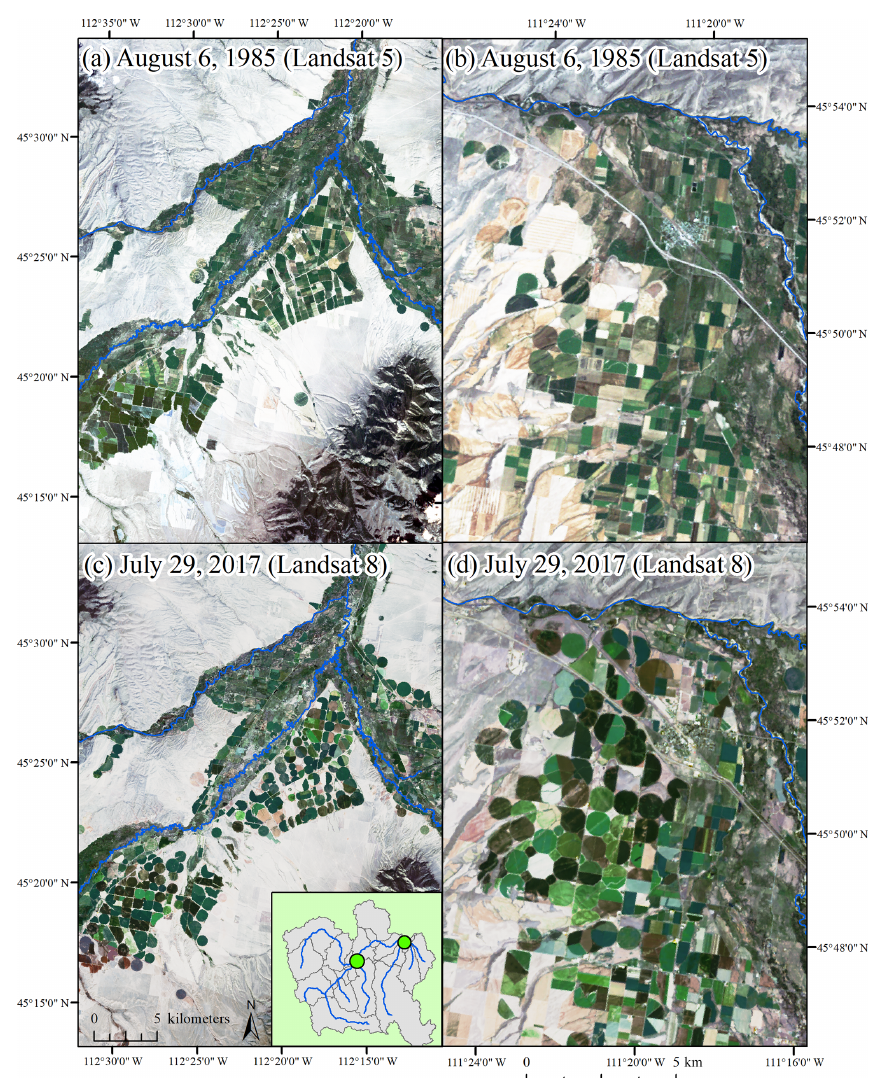
Figure 8. Examples of areas showing a shift in irrigation technique over the past 30 years across the Upper Missouri River headwaters basin, including examples at the confluence of the Beaverhead (center), Big Hole (left) and Ruby River (right), shown in (a) and (c) , as well as examples along Gallatin River, shown in (b) and (d)